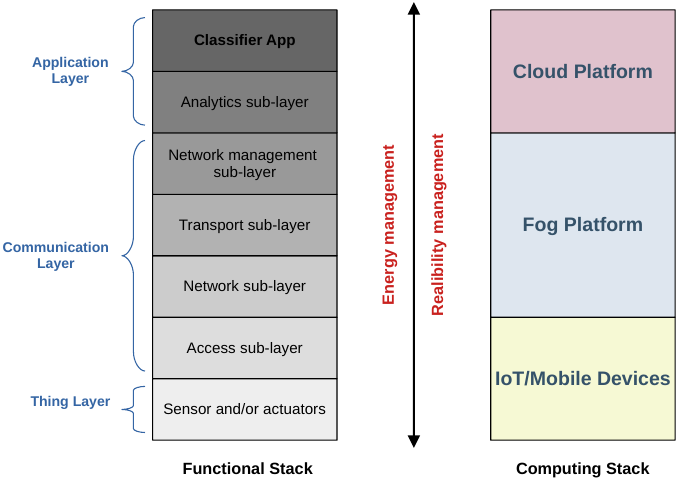
Figure 4. DeepFogSim : the protocol stacks of the considered technological platform of Figure